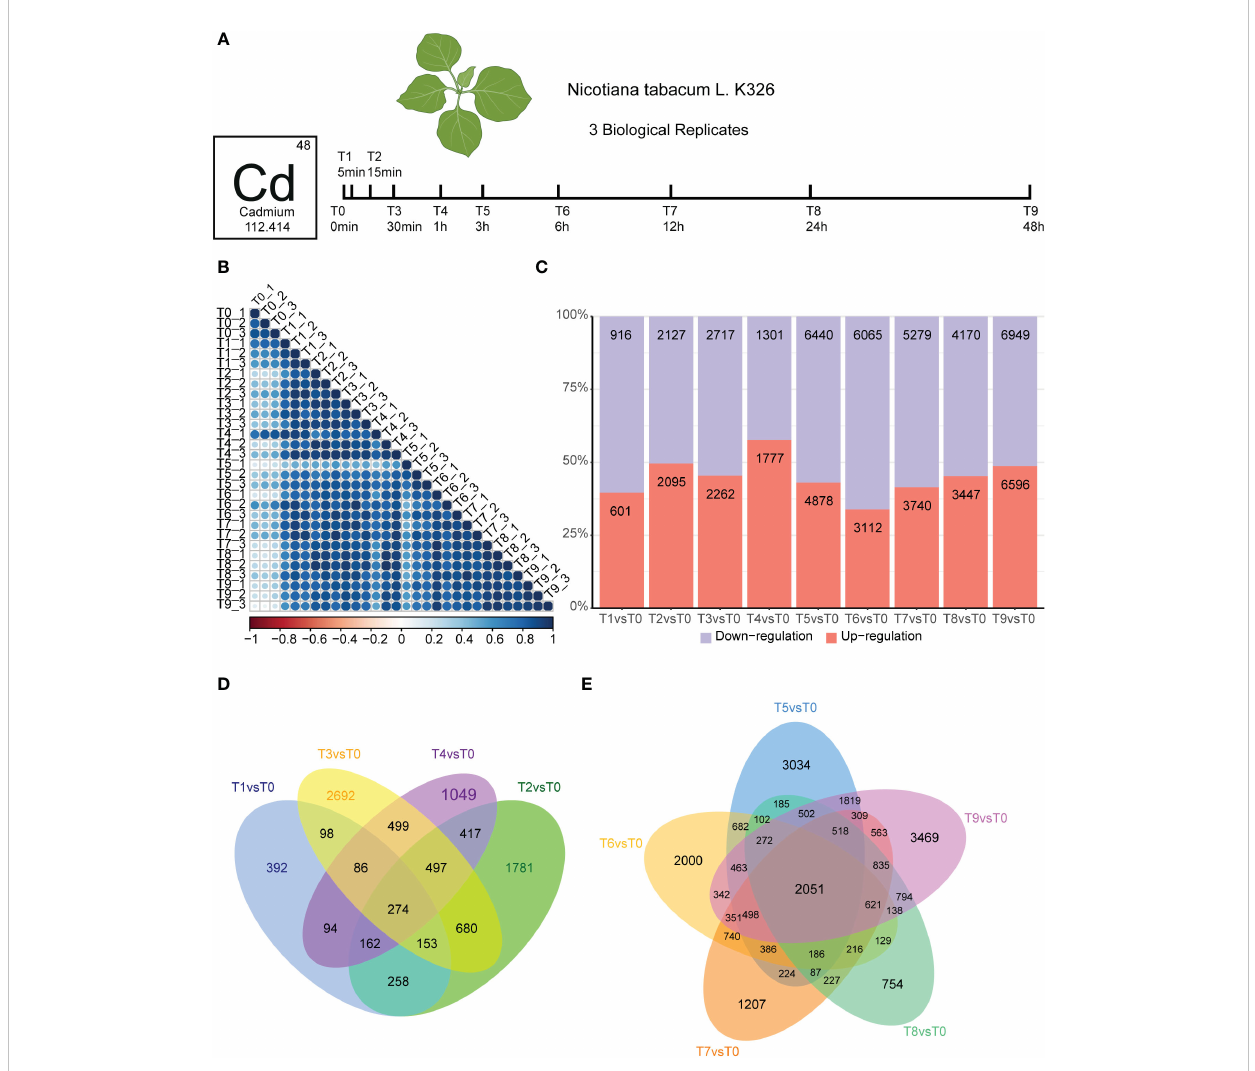
FIGURE 1 Experiment overview and effect of Cd stress response in tobacco root. (A) .Seedlings were incubated in a growth chamber until they grew to the Nicotiana tabacum fi ve-leaf stage, then the roots of seedings were treated with 50 m M CdCl 2 for different times. Three biological replicates of ecotype K326 were harvested. (B) . Heatmap depicting pairwise Pearson correlation of gene expression values of all samples. (C) . Bar graph showing the total number of differentially upregulated (orange) and downregulated (blue) genes in T1vsT0, T2vsT0, T3vsT0, T4vsT0, T5vsT0, T6vsT0, T7vsT0, T8vsT0, and T9vsT0 samples. (D) . Venn diagram showing common and unique genes in T1vsT0, T2vsT0, T3vsT0, and T4vsT0 samples. The number of genes intersecting all time points was 274. (E) . Venn diagrams showing differential gene statistics for T5vsT0, T6vsT0, T7vsT0, T8vsT0, and T9vsT0 samples. The number of genes intersecting all time points was